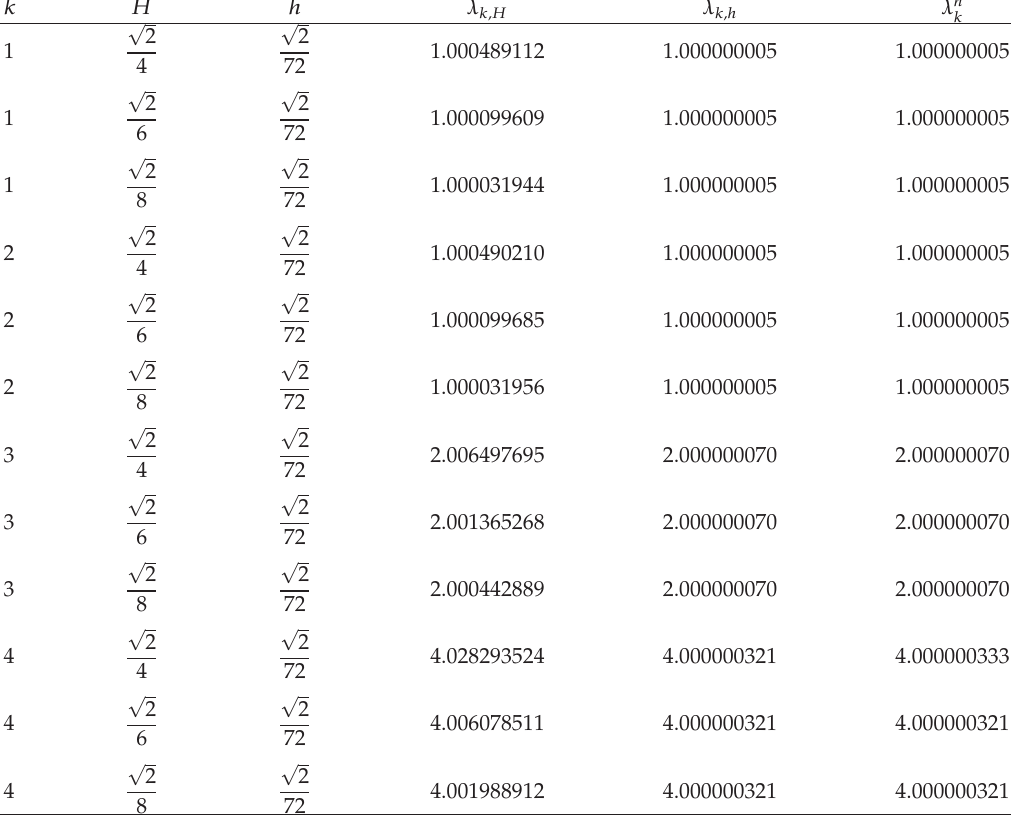
Table 2: The results on the square by Scheme 1 (cid:4) P 2 - P 1 element (cid:5) for eigenvalue problem of electric field (cid:4) r (cid:3) 0 (cid:5) . k